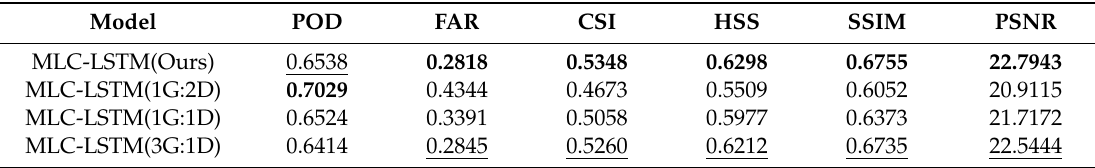
Figure 8. The extrapolation results for echo at Hangzhou, China, 8 August 2016, 23:07 UTC. The last four rows show the results obtained by MLC-LSTM trained with different updating ratios. Table 5. Quantitative evaluation results on six metrics of MLC-LSTM trained with di ff erent updating